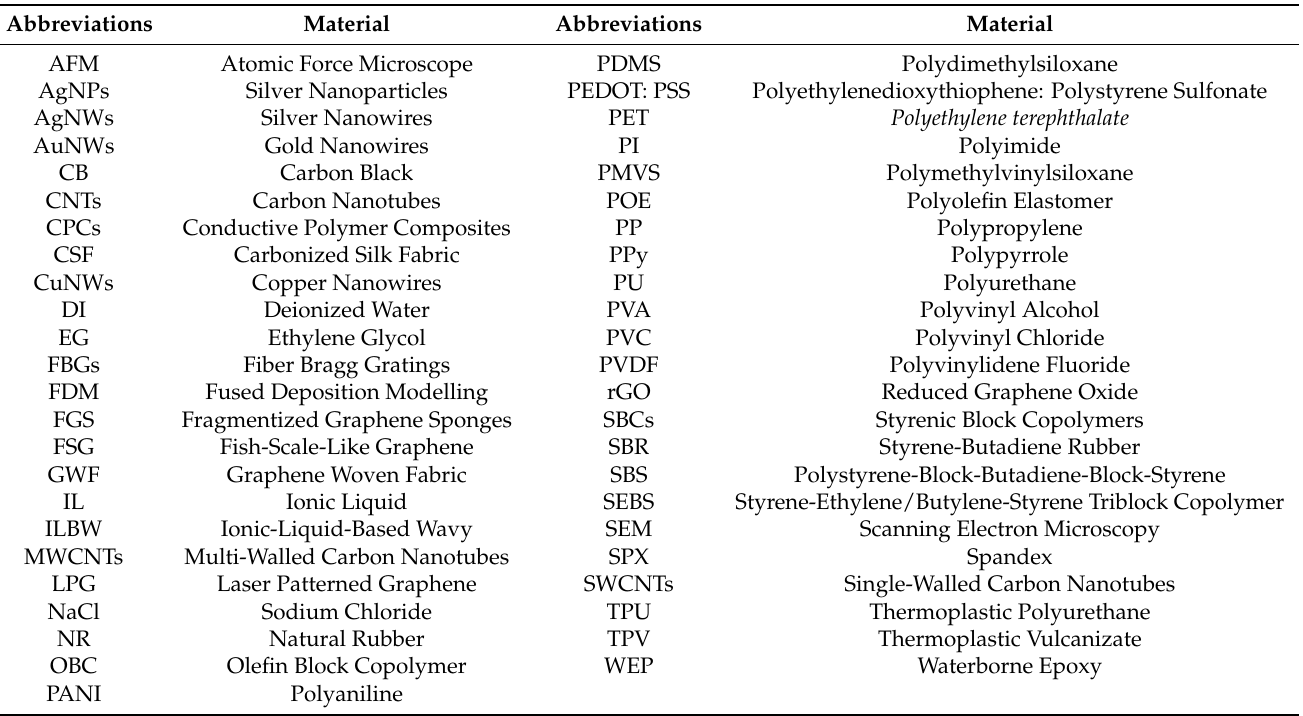
Table 1. Symbols and abbreviations of the